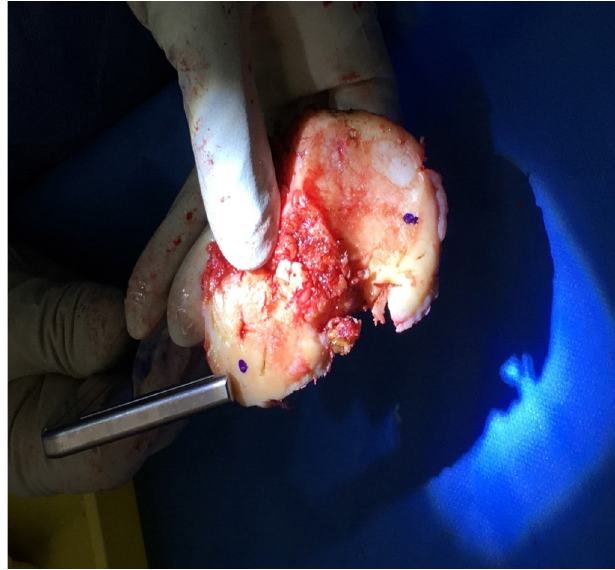
Figure 5. Tibial cut measured from the corresponding points of the plan and recorded for medial and lateral surfaces of tibial plateau. The cuts were measured by the senior surgeon using Vernier Calipers from the corresponding points on the plan (marked with a dot to ensure accuracy) and recorded for medial and lateral surfaces of tibial plateau. Three separate measure- ments were averaged per resection. Table 1. Percentage of resection error. The table below shows the percentage of resection errors (mm) in overall 3618 recordings. They were the difference between the actual measurements taken intraoperatively and the original surgical plan. 24% had resection error of 0.0 and 90% showed a resection error less than 1